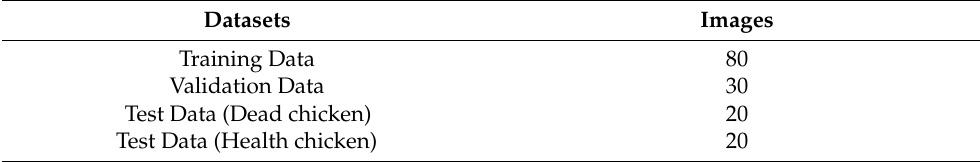
Table 4. Information on the collected